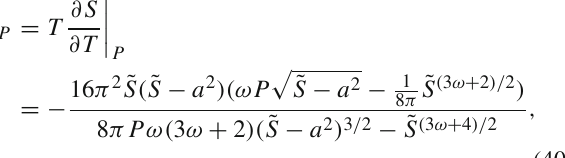
Fig. 8 c p − ˜ s diagram, assuming p = 1, for ω = 1 / 3, ω = − 1 / 6, ω = − 2 / 3 and ω = − 1